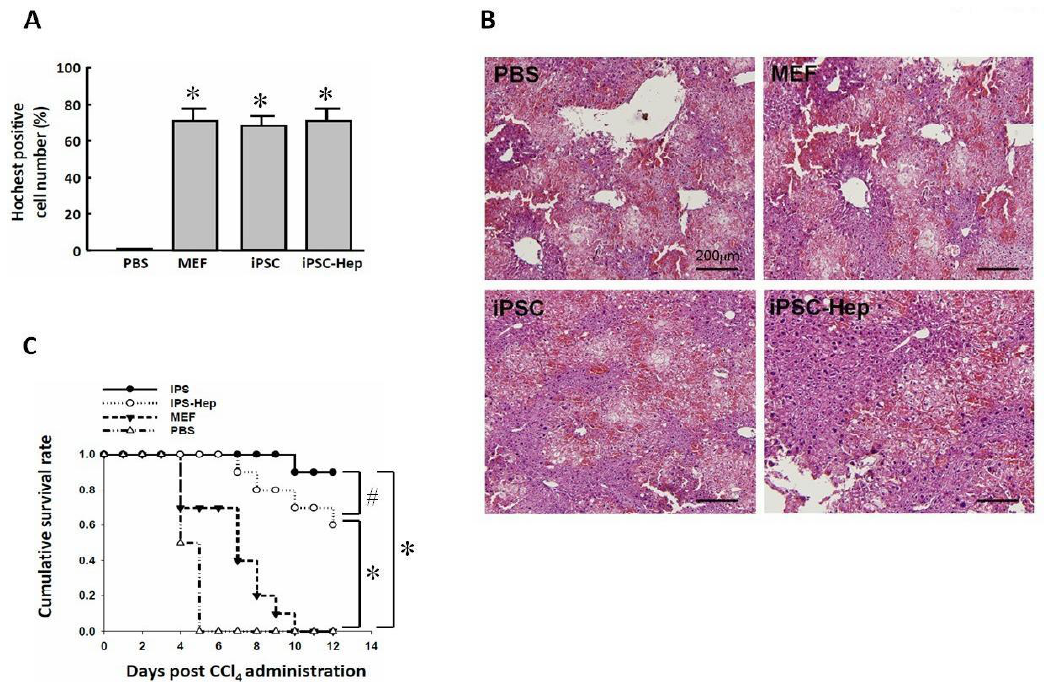
Figure 5. Effect of intraperitoneal cell transplantation (PBS, MEFs, 3-genes iPSCs, or 3-genes iPSC-Heps) on hepatic pathology, survival rate and biochemical parameters in CCl -treated recipients. ( A ) Hoechst-stained cell engraftment in the CCl 4 recipients of PBS, MEFs, iPSCs, or iPSC-Heps; ( B ) Representative H & E stain of CCl4-treated liver tissue 24 h after receiving iPSCs, iPSC-Heps, MEFs or PBS treatment; ( C ) Intraperitoneal transplantation of 3-genes iPSCs or 3-genes iPSC-Heps rescued mice from lethal AHF. Data shown here are the mean ± SD of six independent experiments. In panel, * P < 0.05 vs . PBS. In panel C, * P < 0.05 vs . PBS or MEFs. # P < 0.05 vs . iPSC-Heps.